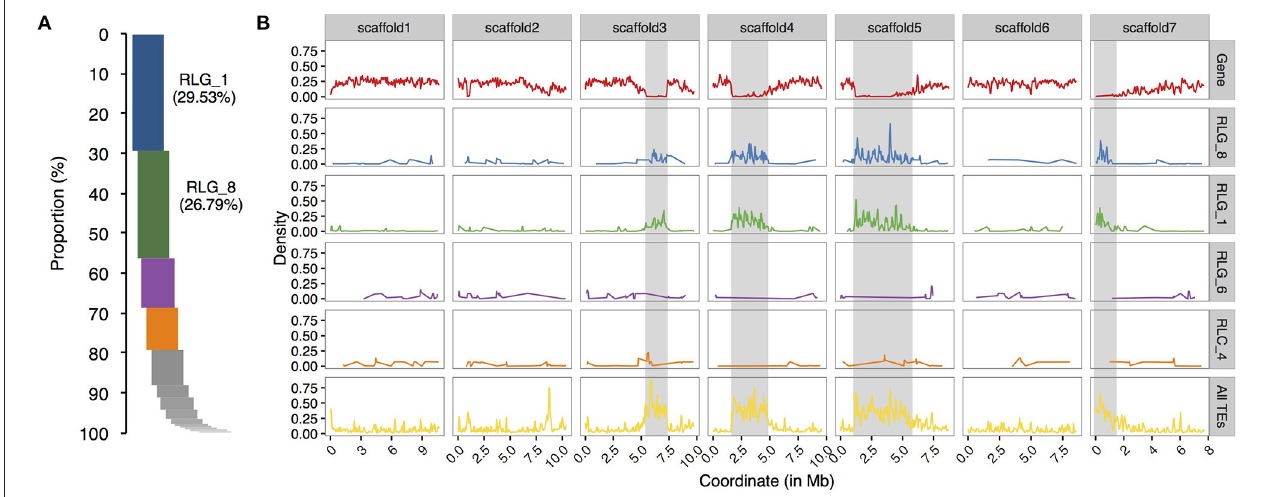
FIGURE 2 | Relative proportion and chromosome distribution of LTR retrotransposon families in S. alba . (A) Proportions of intact copy numbers from different LTR retrotransposon families ranked in a descending order. Note that RLG_1 and RLG_8 are the top two abundant LTR retrotransposons in S. alba . (B) Chromosome distribution of coding genes (the upper row), the top four abundant LTR retrotransposon families (RLG_1, RLG_8, and RLG_4 of Gypsy and RLC_6 of Copia ), and all TEs along the seven largest scaffolds of the S. alba genome. The putative heterochromatin regions (gene density < 0.05) are indicated with the gray shadow. Note that the distributions of RLG_1 and RLG_8 elements track the genomic locations of putative heterochromatic regions but no such pattern is observed for RLG_4 and